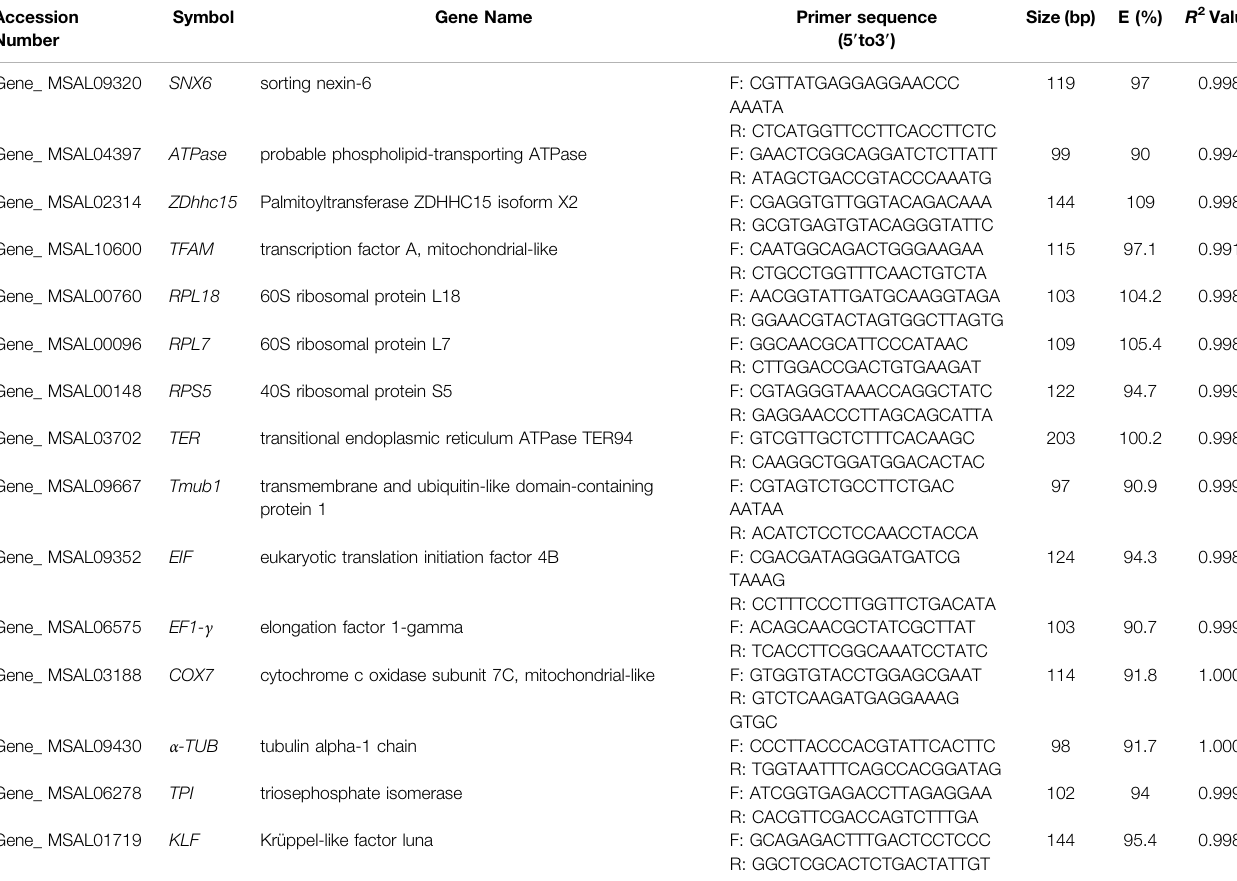
TABLE 1 | Primer sequences and ampli fi cation characteristics of candidate reference